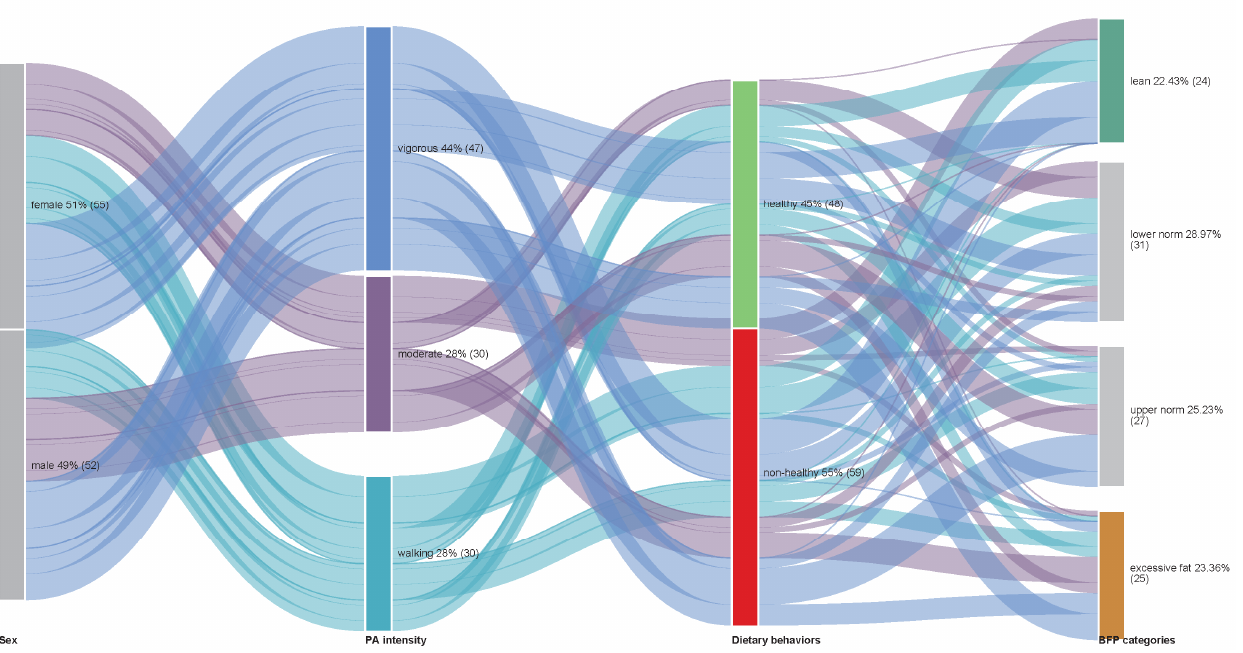
Figure 4. Sankey diagram of the relationship trajectories between dominant physical activity intensity and healthy and unhealthy dietary behaviors based on the prevalence of participants in body fat percentage categories. The width of the links is proportional to the number of individuals.